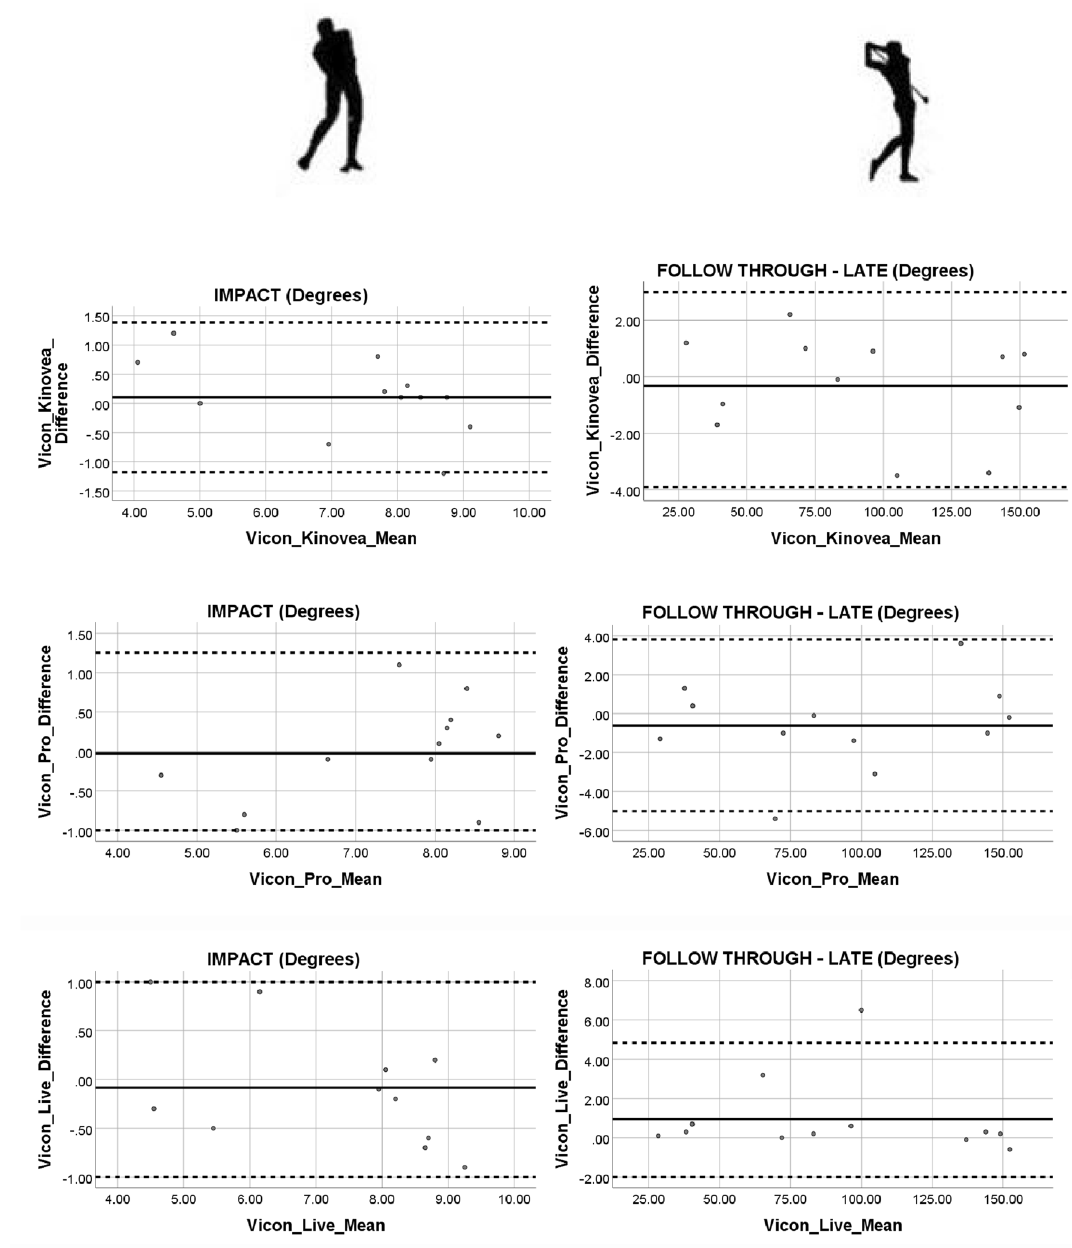
Figure 4. Impact and follow through (late) difference against mean for software data. Both phase measurements are reported in joint angle